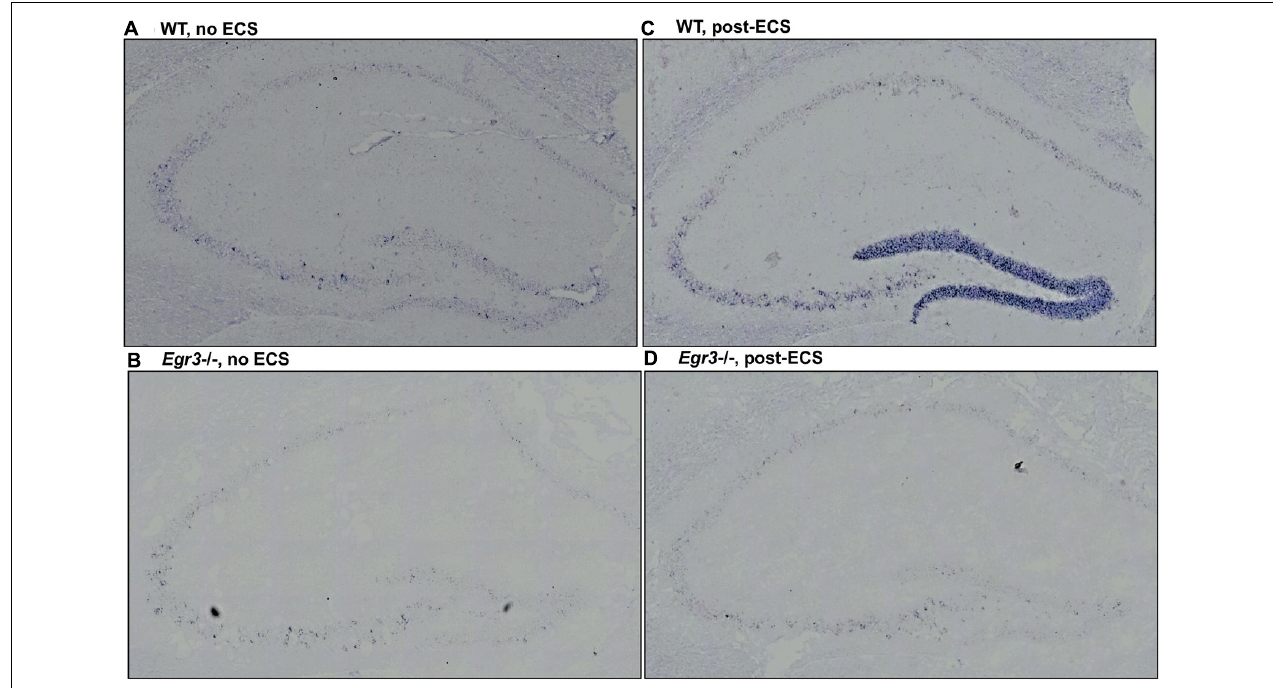
FIGURE 3 | Bdnf induction in the hippocampal dentate gyrus requires Egr3 . Representative tissue sections demonstrating in situ hybridization labeling of Bdnf mRNA expressing cells in the hippocampus of WT and Egr3 –/– mice at baseline (A,B) and 1 h following ECS (C,D) . (A) Bdnf is expressed sparsely in CA3, CA2, and the DG of WT mice at baseline. (C) ECS induces high-level Bdnf expression in the DG, and increased expression in CA3, CA2, and CA1 of WT mice. (B) Bdnf expression in Egr3 –/– mice is limited to rare cells in the CA3 region of the hippocampus, with no clear expression above background in the DG, CA2, or CA1, at baseline. (D) ECS produces little to no increase in Bdnf expression in the DG, CA3, CA2, and CA1 regions of Egr3 –/– mice.